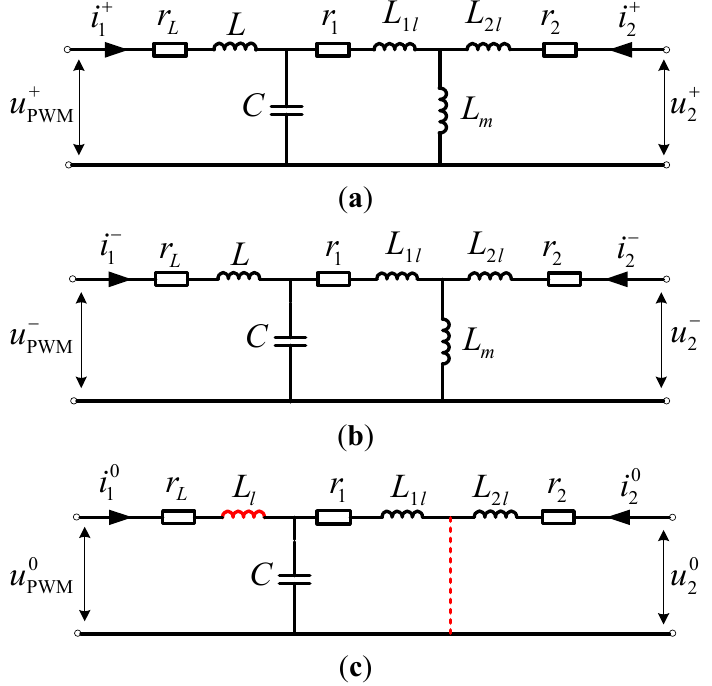
Figure 5. ISC equivalent circuits for three-phase inverters: ( a ) IPSC; ( b ) INSC; ( c )